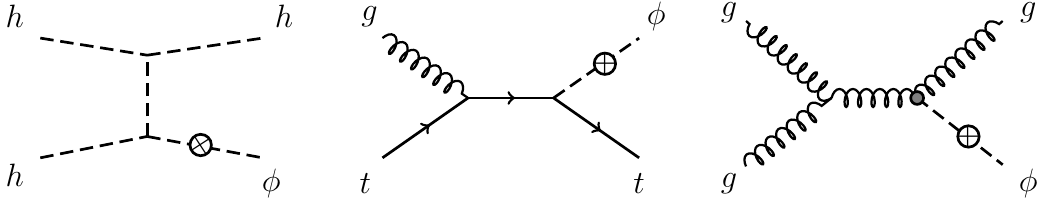
Figure 2 . Representative Feynman diagrams giving contributing to (cid:30) freeze in production in the early universe. These processes determine (cid:26) (cid:30) which (in addition to (cid:26) (cid:31) ) determines the hidden sector’s temperature T D . The e(cid:11)ective vertex in the right diagram arises from integrating out the top quark for energies in between the weak scale and the QCD con(cid:12)nement scale (see appendix